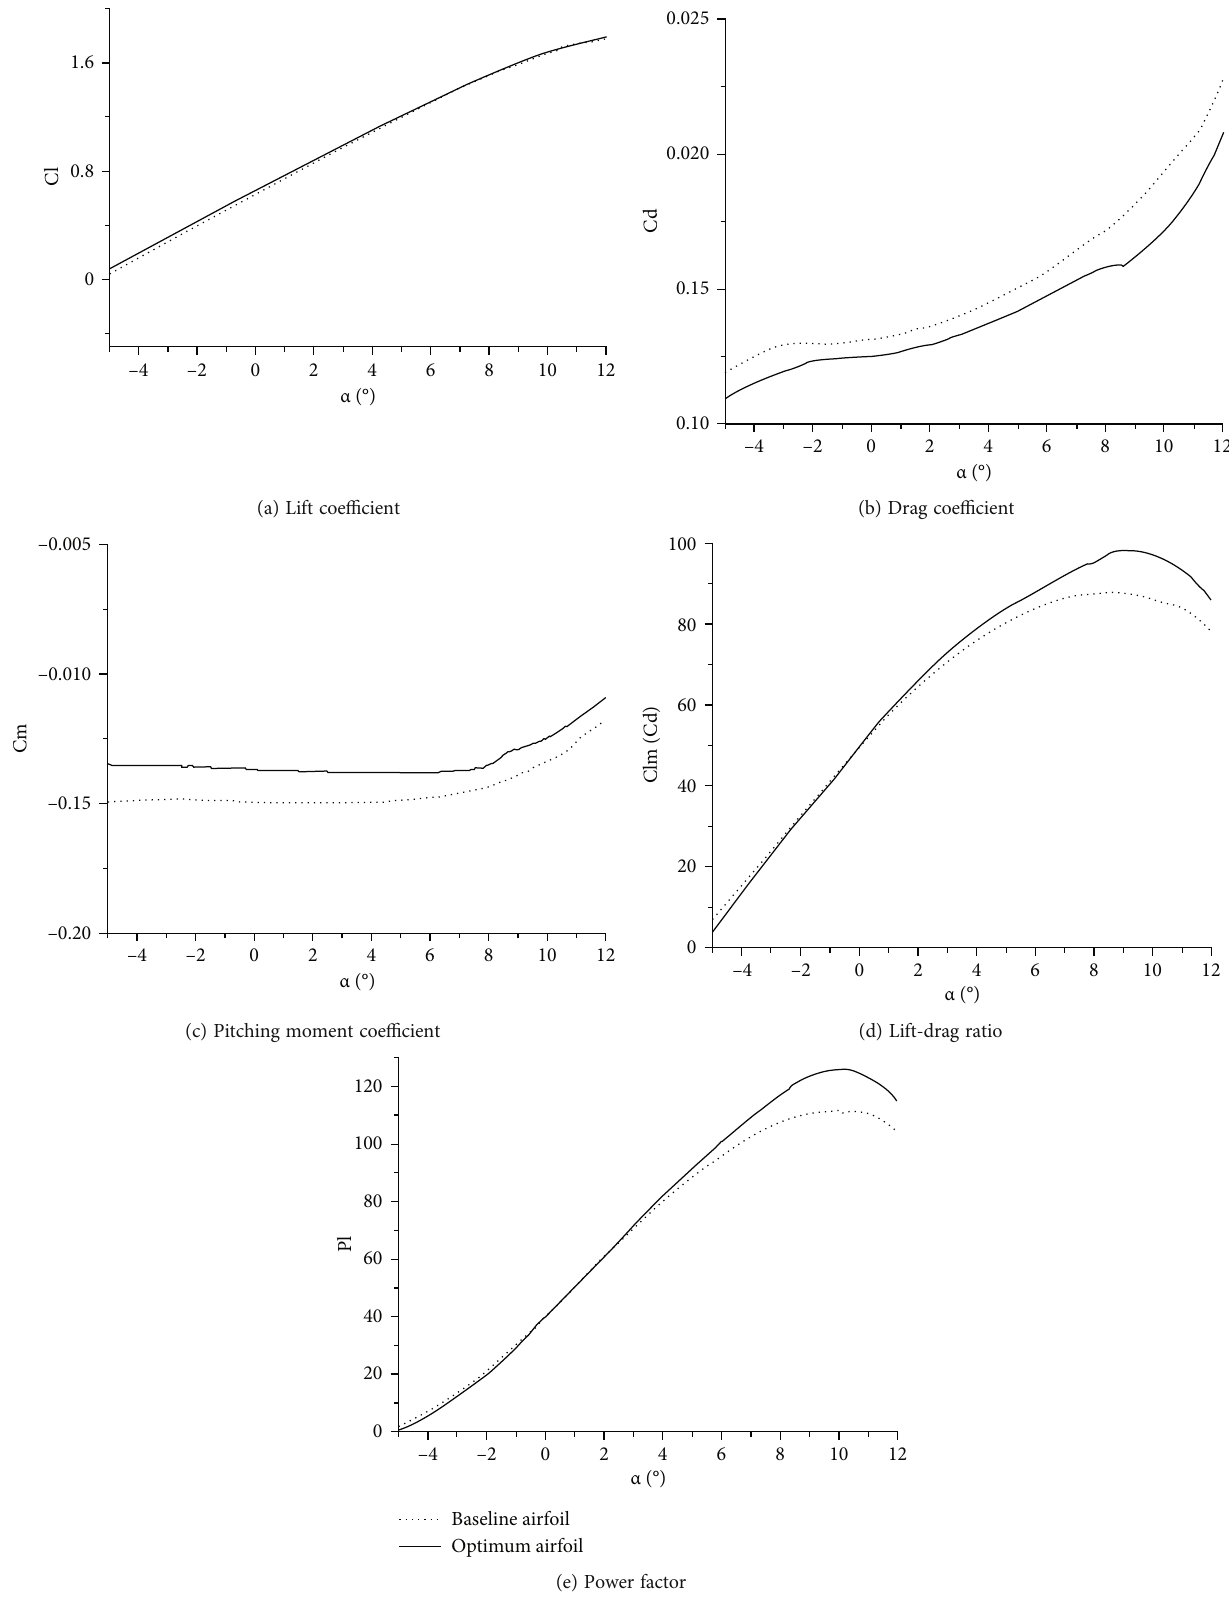
Figure 11: Aerodynamic characteristics of airfoil with angle of